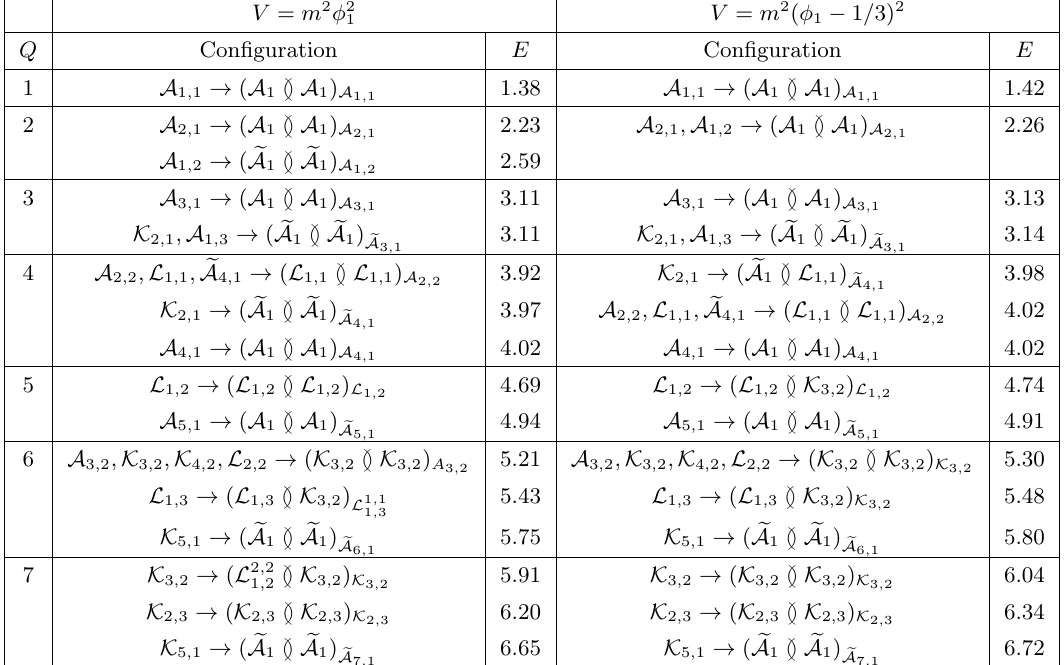
Table 3 . Initial guesses and (cid:12)nal solutions together with the (cid:12)nal rescaled energies of the Hop(cid:12)ons in the sectors of degrees Q = 1 (cid:0)